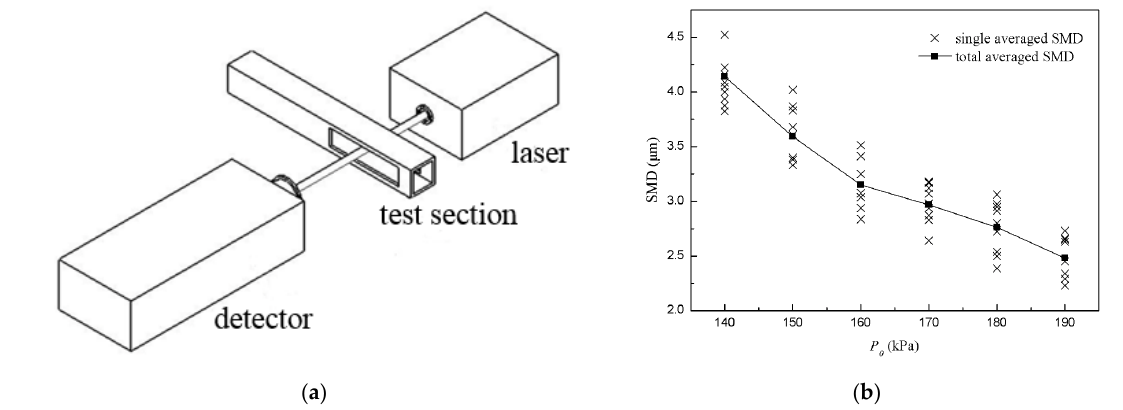
Figure 4. Optical diagram of laser particle size analyzer and SMD measurements of aerosol. ( a ) Optical diagram of laser particle size analyzer; ( b ) SMD measurements of aerosol of toluene/O 2 /N 2 at different P 0 .